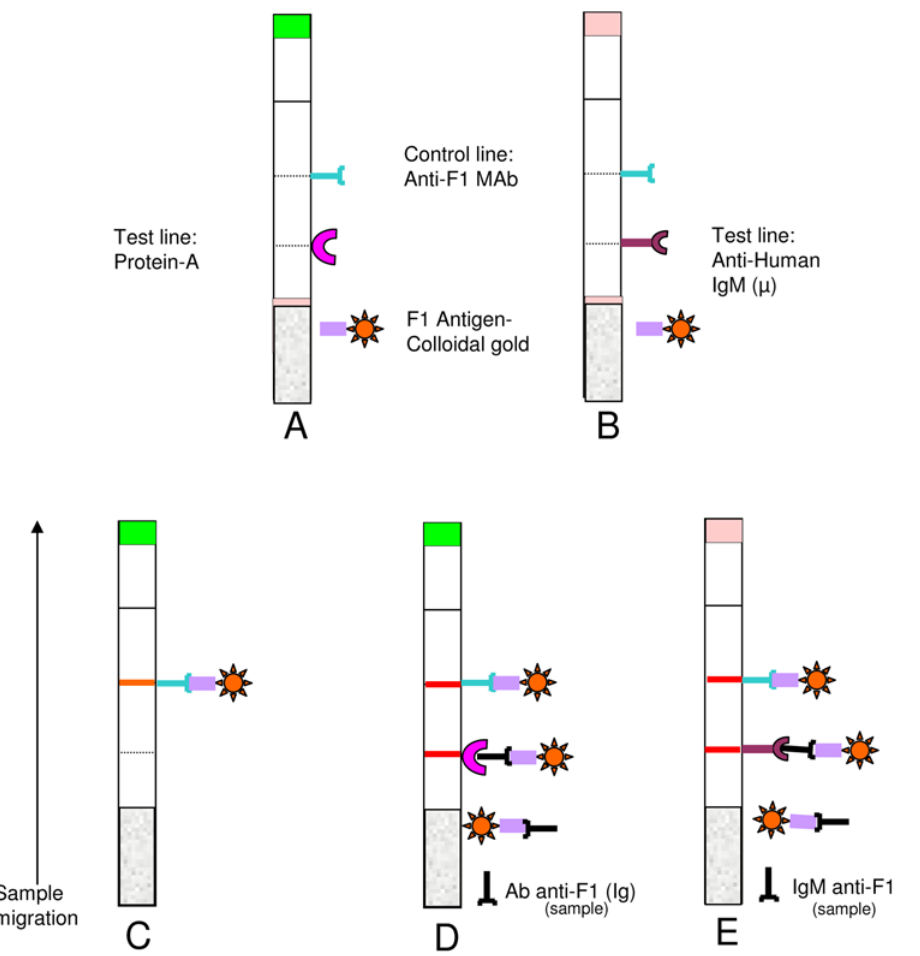
Figure 2. Principle of the dipstick test. A: SIgT test, B: HIgM test, C: Negative test, D: Positive test for Ig anti-F1, E: Positive test for IgM anti-F1.